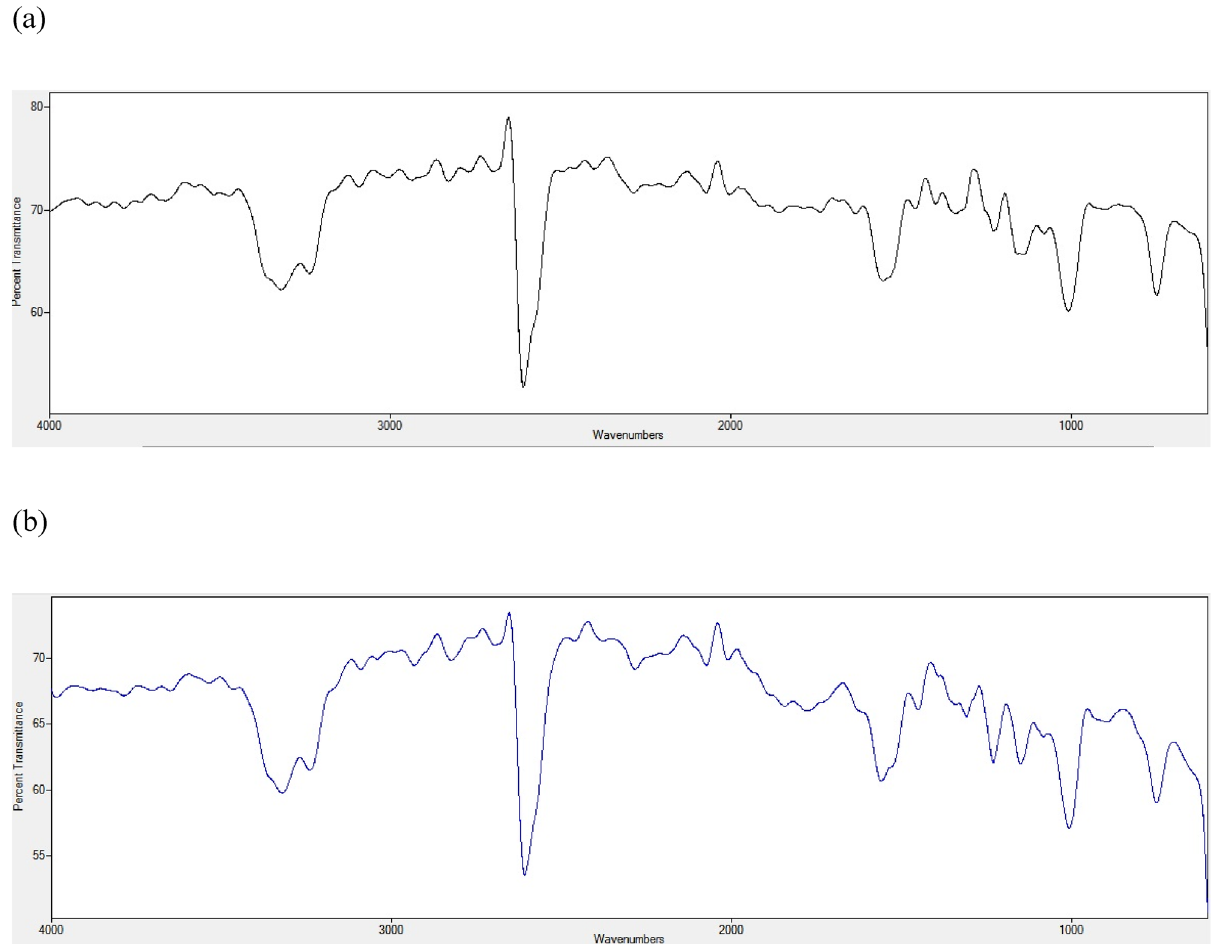
Figure 2. FTIR of ( a ) raw chicken feather and ( b ) keratin obtained following NaOH hydrolysis of chicken feather.